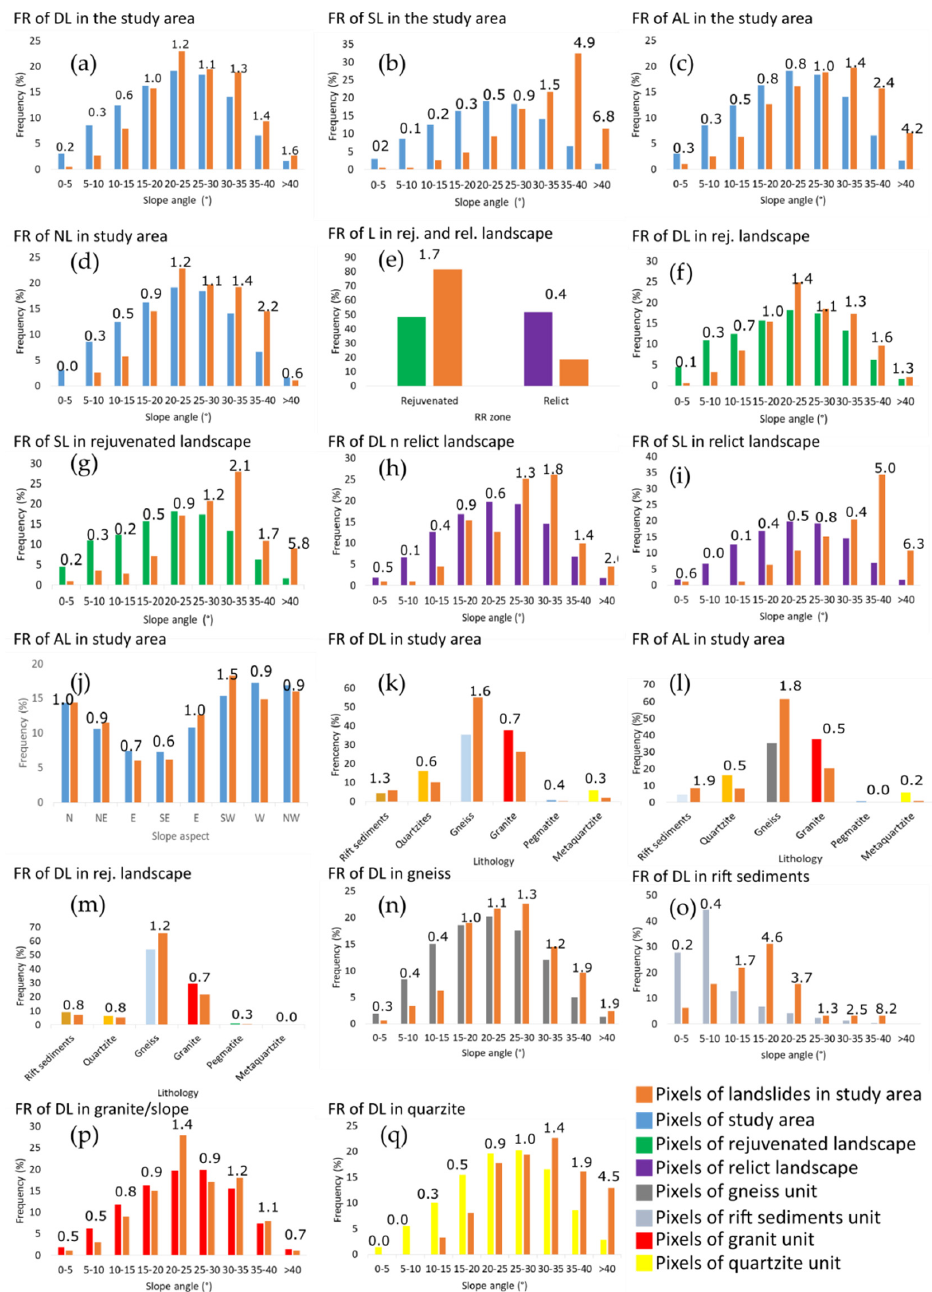
Figure 8. Frequency distributions for landslides (orange bars; each landslide is represented by one pixel over its depletion area) and for all pixels outside the landslide bodies in the entire study area, rejuvenated, and relict landscapes (blue, green, and violet bars respectively). The other bars (grey, blue-grey, red, and yellow) are landslides distributions within the different lithologies; respectively in gneiss, rift sediments, granite, and quartzite. ( a – d ) Slope angle in study area respectively for deep-seated (DL), shallow (SL), active (AL), and non-active (NL) landslides; ( e ) landslide distribution within the differentiation of rejuvenated and relict landscape; ( f , g ) slope angle in the rejuvenated landscape respectively for deep-seated and shallow landslides; ( h , i ) slope angle in relict landscape respectively for deep-seated and shallow landslides; ( j ) slope aspect for active landslides; ( k , l ) lithology in study area respectively for all deep-seated and active deep-seated landslides; ( m ) lithology in the rejuvenated landscape for deep-seated landslides; ( n – q ) slope angle respectively in gneiss, rift sediments, granite, and quartzite for deep-seated landslides. For each class, the corresponding frequency ratio (FR) is indicated.